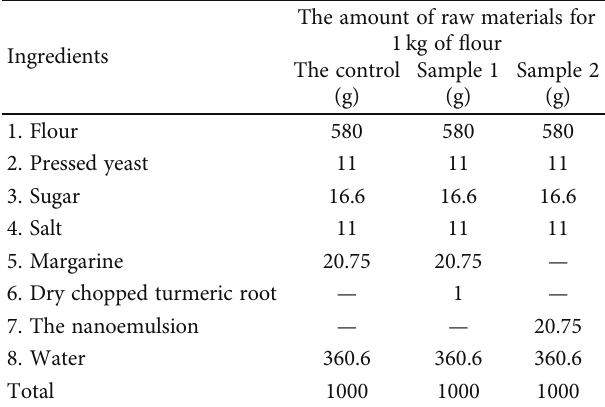
Table 1: Formulation prototype wheat bread.